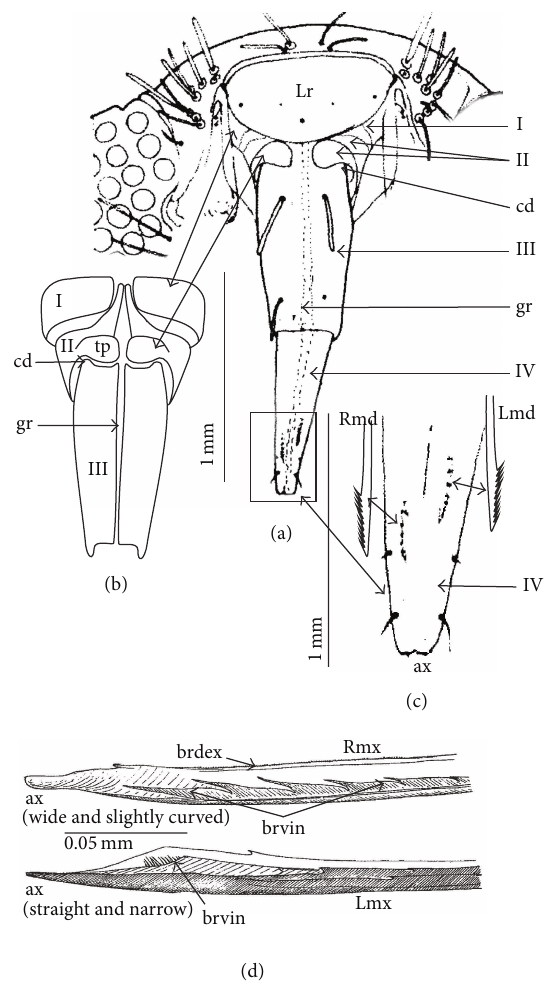
Figure 3: Morphological characters of the labium, maxillary, and mandibular stylets of the Potamocoridae. (a) The labium of Potamo- coris nieseri according to von Doesburg [18]. (b) Shapes of the first (I) and second (II) segments of the labium of Potamocoris nieseri are presented as presumable shapes deduced presently by Bro˙zek. (c) Magnification of the IV segment (black dots inside the segment point out the presence of mandibles). The drawings of mandibles (Rmd and Lmd) showing putative shapes of the mandibular file (a precise description based on the original drawing by von Doesburg [18] was impossible). (d) The shape of the right and left maxillae (Rmx and Lmx) of Potamocoris sp . shown on the basis of a drawing taken from Cobben [19]. The right apex (ax) is wider than the left one; the right apex is slightly curved while the left one is straight and narrow. The inner system of spines on the maxillae edges from the reduced and hidden rupturing device (brdex and brvin). On the right maxilla seven short spines are present on the internal ventral side (brvin). On the dorsal side the spines are strongly reduced (brdex). On the left maxilla, internally, one tuft of short spines (brvin) can be observed. I: first segment, II: second segment, III: third segment, IV: fourth segment, ax: apex of maxillae, cd: dorsal condyle (the articulation between the second and third segments on the dorsal surface), gr: labial groove, tp: triangular plate of the second segment, Lr: labrum, Rmd: right maxilla, Lmx: left maxilla, Rmd: right mandible, Lmd: left